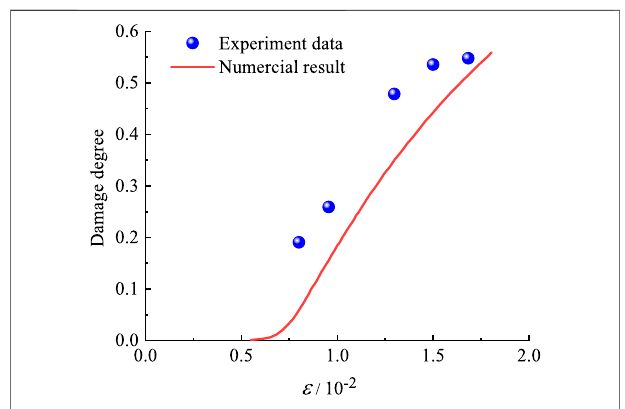
FIGURE 5 | Comparison of damage evolution curve between numerical results and experimental data.